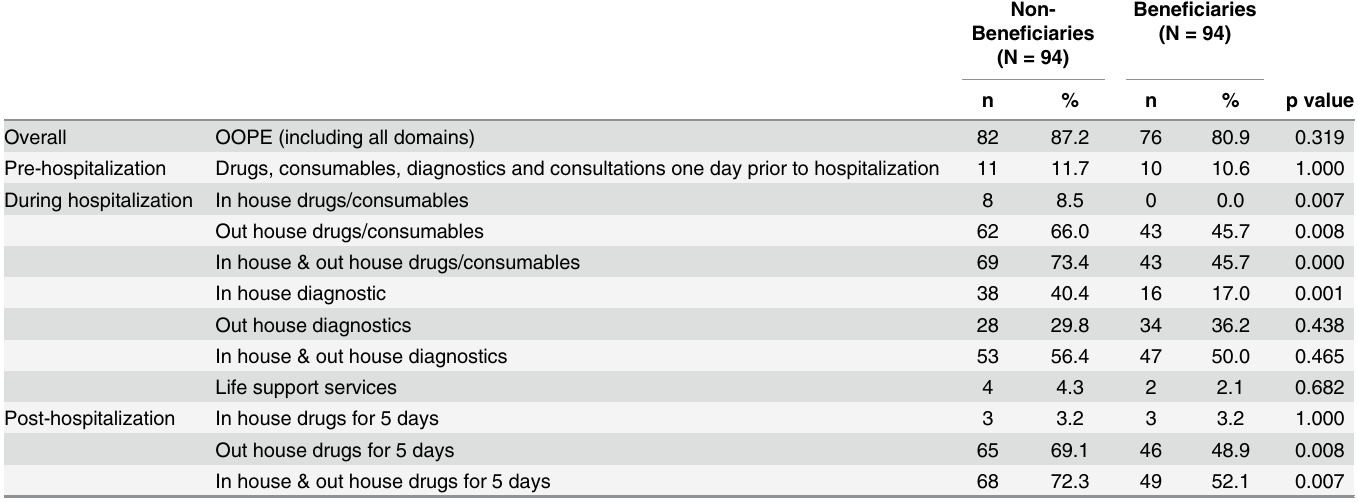
Table 3. Proportion who incurred out of pocket expenditure (OOPE) among non-beneficiaries and beneficiaries, Solan, Himachal Pradesh, India,